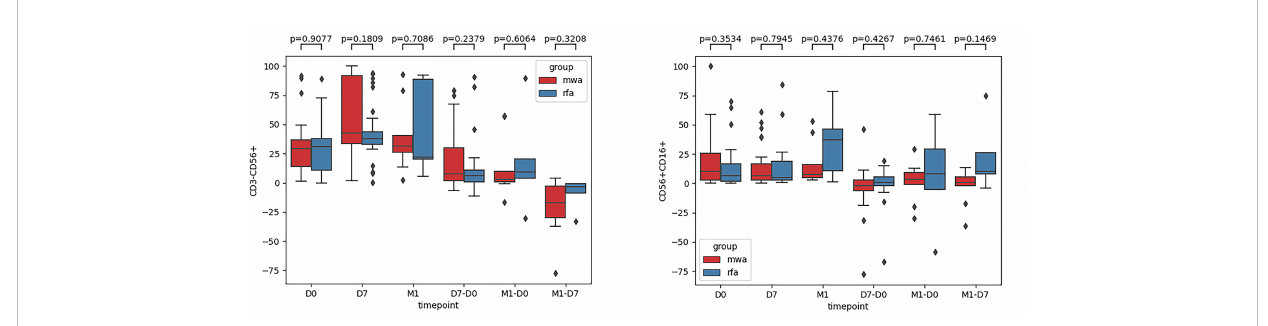
FIGURE 2 The frequencies of CD3-CD56+ and CD3-CD56+CD16+ in NK cells of the RFA group and WMA group were compared. It was suggested that D0 (P=0.91, P=0.35), D7 (P=0.18, P=0.79), M1 (P=0.71, P=0.44), D7-D0 (P=0.24, P=0.43), M1-D0 (P=0.61, P=0.75), M1, and D7 (P=0.32, P=0.15) in the two groups had no